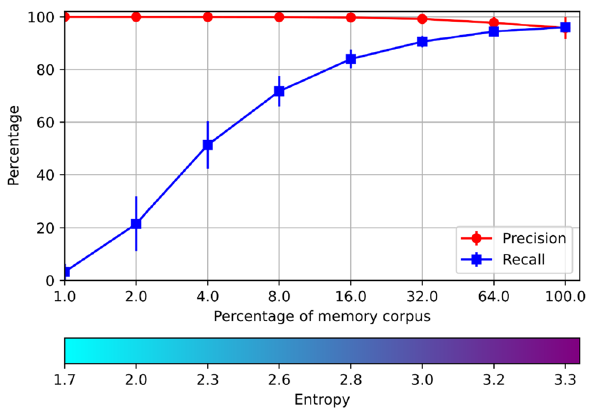
Figure 5. Results of experiment 3.